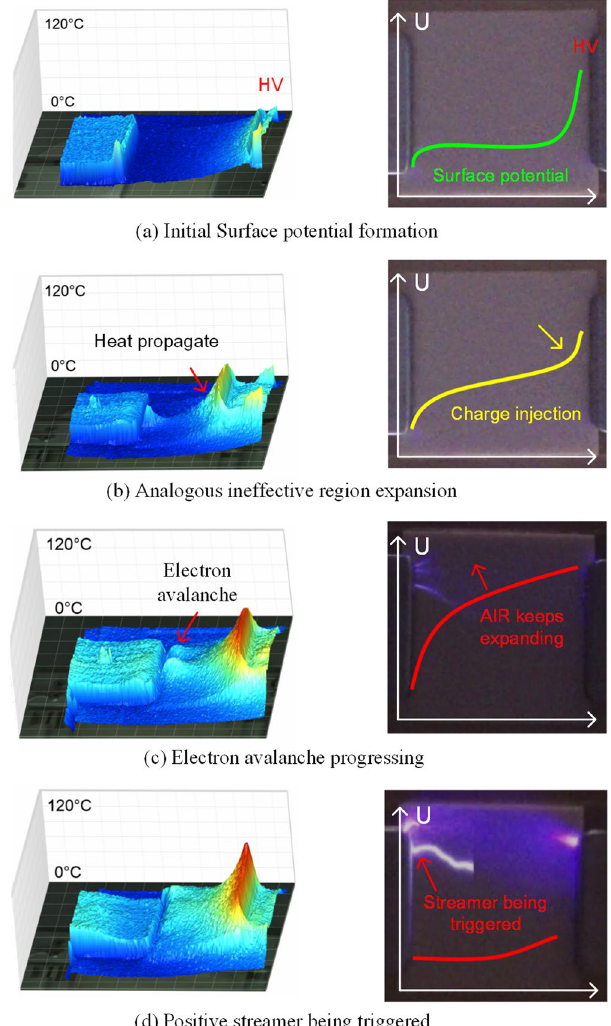
Figure 4. Thermal image and surface streamer picture with the temperature of the HV electrode increasing from 30 °C to 100 °C at 35 kV: ( a ) Initial potential formation stage, ( b ) electron avalanche incepted due to formation of “analogous ineffective region”, ( c ) electron avalanche progressing, and ( d ) surface flashover being